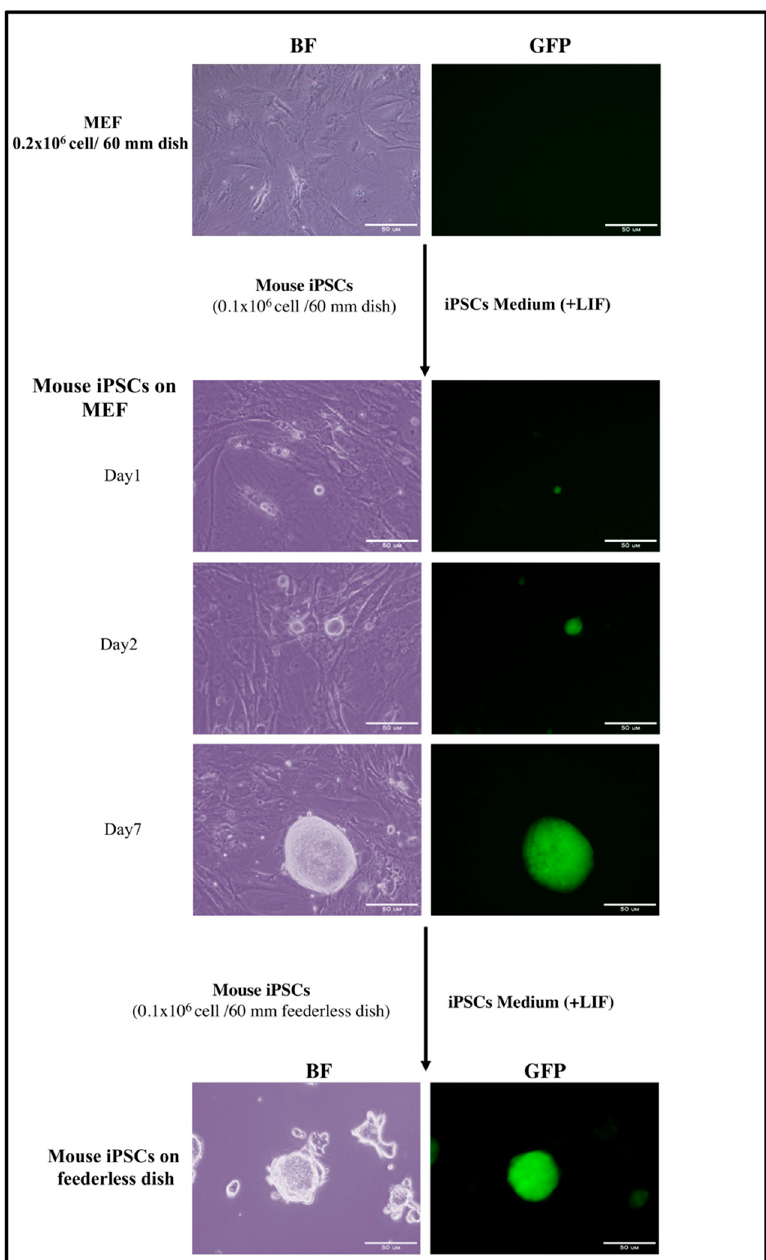
Figure 2. Representative images of mouse induced pluripotent stem cell (iPSC) / embryonic stem cell (ESC) viability maintenance in the presence of leukemia inhibitory factor (LIF). iPSCs / ESCs seeded om MEF feeder cells for at least one week until forming colonies without differentiation. These colonies were transferred to feederless gelatin-coated dish prior to start conversion. Stemness tracking during maintenance by the presence of GFP protein. Scale bar: 50 μ m.